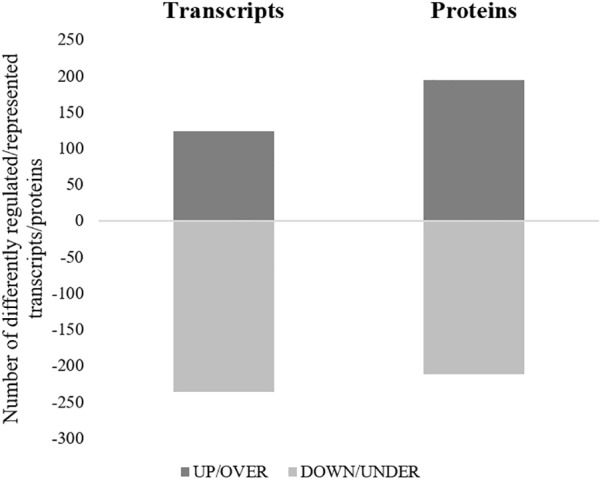
Representation of differentially regulated/represented transcripts/proteins of R. annulatus females in response to B. bigemina infection. For each approach, the number of transcripts (left column) or proteins (right column) differently regulated or represented are shown. Dark gray = up-regulated transcripts/over-represented proteins, Light gray = down-regulated transcripts/under-represented proteins.